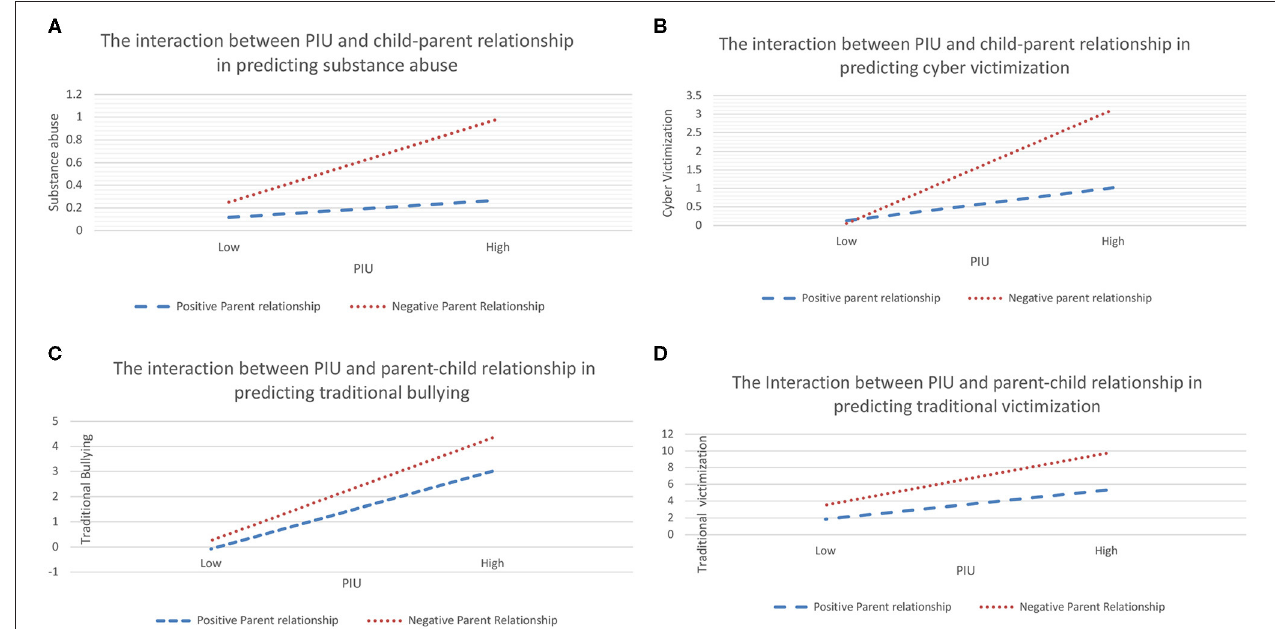
FIGURE 1 | (A) Simple slope analysis shows that parent–child relationship moderated the relation between PIU and substance abuse. The function was graphed for two levels of independent variable and moderator: 1 SD above the mean and 1 SD below the mean. (B) Simple slope analysis shows that parent–child relationship moderated the relation between PIU and cybervictimisation. The function was graphed for two levels of independent variable and moderator: 1 SD above the mean and 1 SD below the mean. (C) Simple slope analysis shows that parent–child relationship moderated the relation between PIU and traditional bullying. The function was graphed for two levels of independent variable and moderator: 1 SD above the mean and 1 SD below the mean. (D) Simple slope analysis shows that parent–child relationship moderated the relation between PIU and traditional victimisation. The function was graphed for two levels of independent variable and moderator: 1 SD above the mean and 1 SD below the